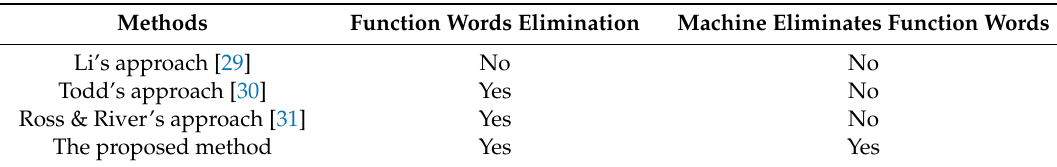
Table 7. A comparison of research methods in ESP